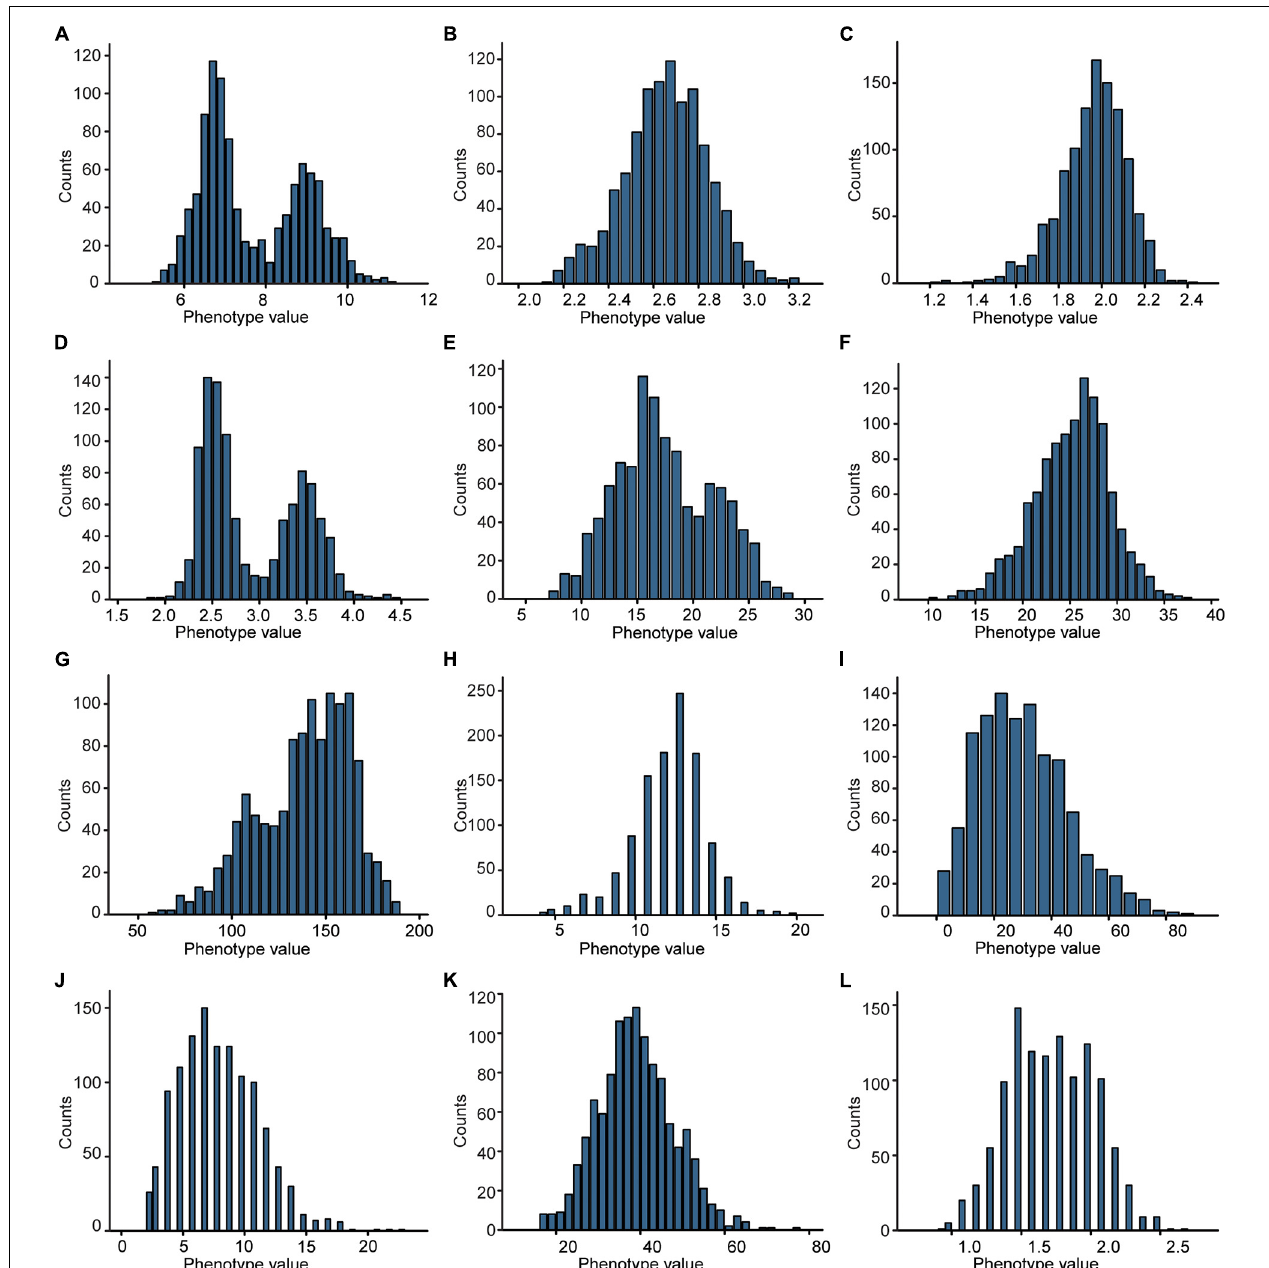
FIGURE 2 | Frequency distribution of the 12 agronomic traits in the F 2 population. (A) GL, grain length. (B) GW, grain width. (C) GT, grain thickness. (D) LWR, length to width ratio. (E) TGW, thousand-grain weight. (F) PL, panicle length. (G) PH, plant height. (H) PB, primary branch number. (I) SB, secondary branch number. (J) TN, tillering number. (K) FLL, flag leaf length. (L) FLW, flag leaf